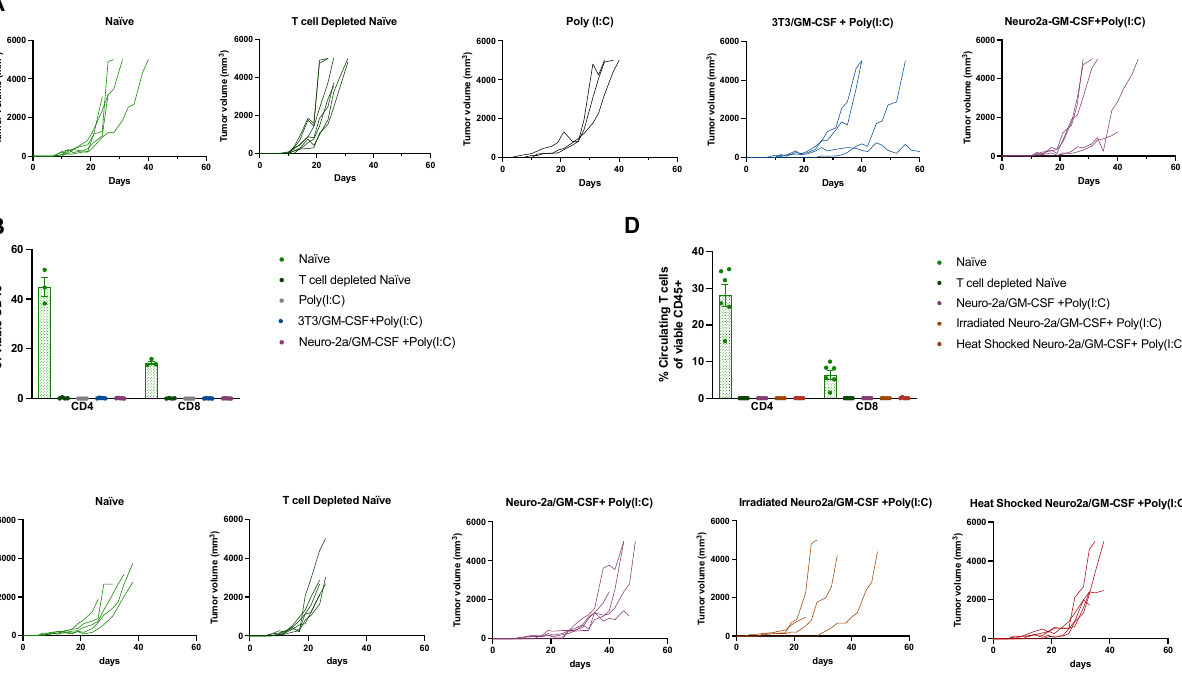
Figure 3. T-cell depletion of mice with prior A20 tumor immunity induced by intratumoral injections of Poly(I:C) and GM-CSF-secreting cells allows for tumor growth upon rechallenge. ( A – D ) Tumor-free mice at day 120 following the initial A20 tumor challenge were depleted of T cells as described in Section 2 and were challenged with A20 tumor for a third time on the upper right flank. Tumors were sized 2–3 times per week and mice were removed from study once a tumor size of >5000 mm 3 was reached, when tumors became highly ulcerated (>50% visible area) or when moribund. Graphs of individual mouse tumor growth in T-cell-depleted mice from ( A ) Figure 1 or ( C ) Figure 2. ( B , D ) T-cell depletion was confirmed by evaluating CD4 and CD8 T cell percentages in blood via flow cytometry, as described in Section 2. The percent of circulating T cells per group is illustrated for mice from ( B ) Figure 1 or ( D ) Figure 2, using week 2 depletion data as a representative timepoint.